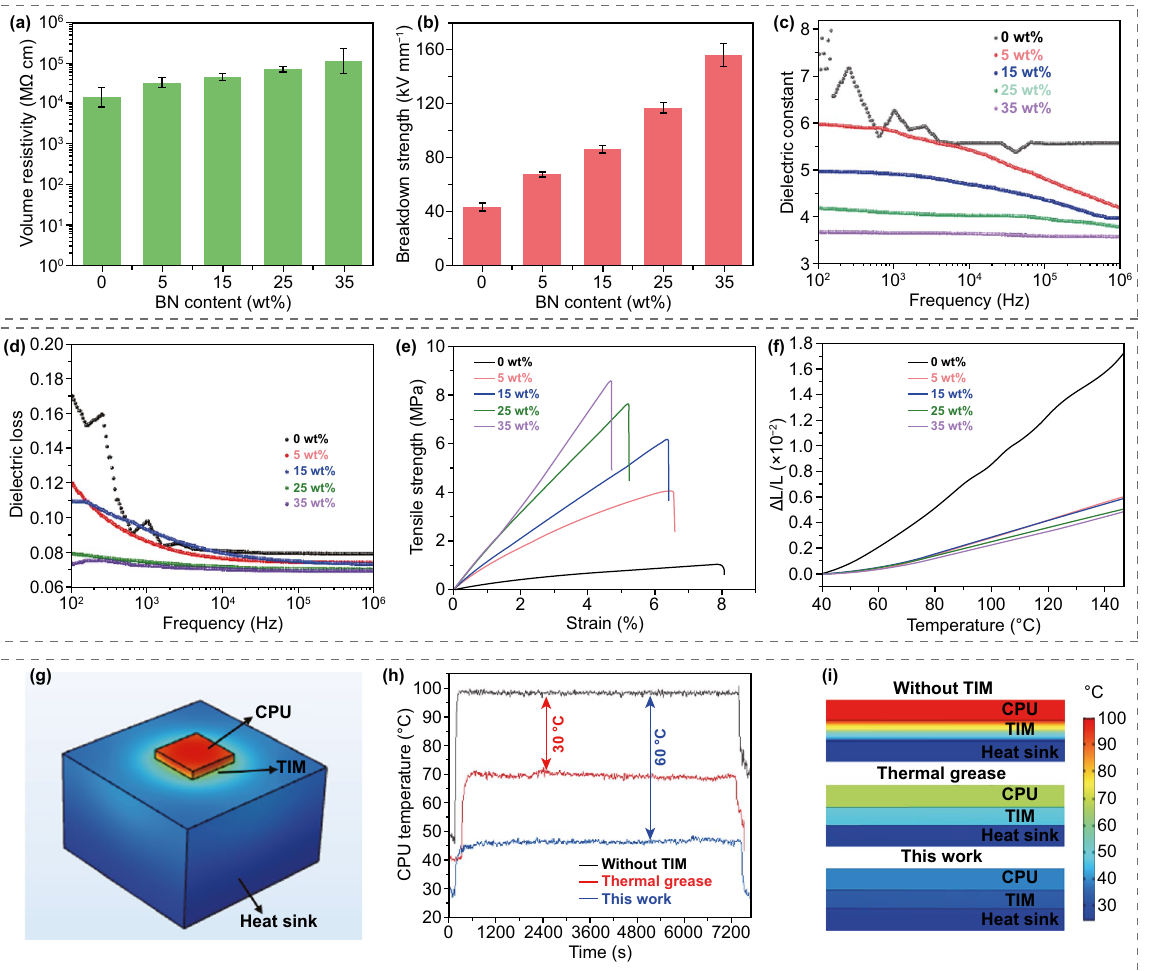
Fig. 5 Basic performance and thermal management capability of the polymer/s-BN composite film. a Volume resistivity, b breakdown strength, c dielectric constant, d dissipation factor, e typical tensile stress curves and f dimension changes with temperature for polymer/s-BN composite films with different BN contents. g Configuration for TIM performance measurement. h Core temperature evolution curves for the CPU with or without TIMs as a function of time. i Cross-sectional temperature distribution of the TIM obtained based on the system in g . The CPU with our sample shows the lowest temperature since the composite film can effectively transfer heat to the heat